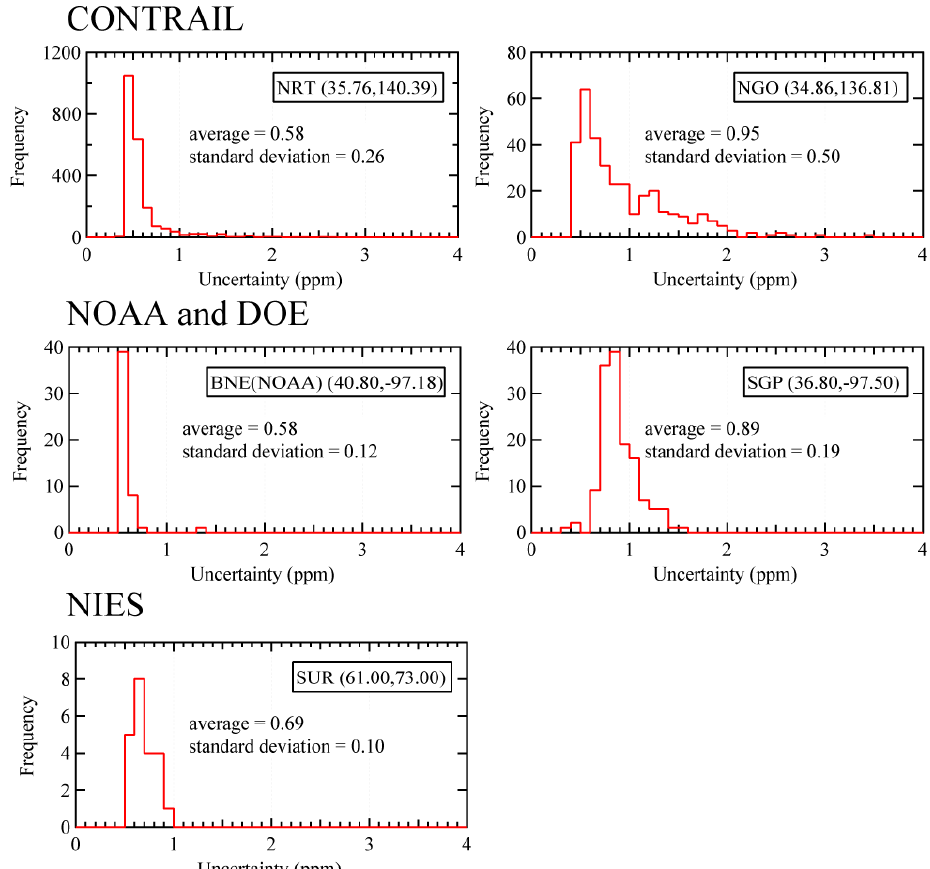
Figure 5. Frequency distributions of the estimated uncertainties at five sites. The Fig. 5. Frequency distributions of the estimated uncertainties at five sites. The size of each frequency class is size of each frequency class is 0.1 ppm.